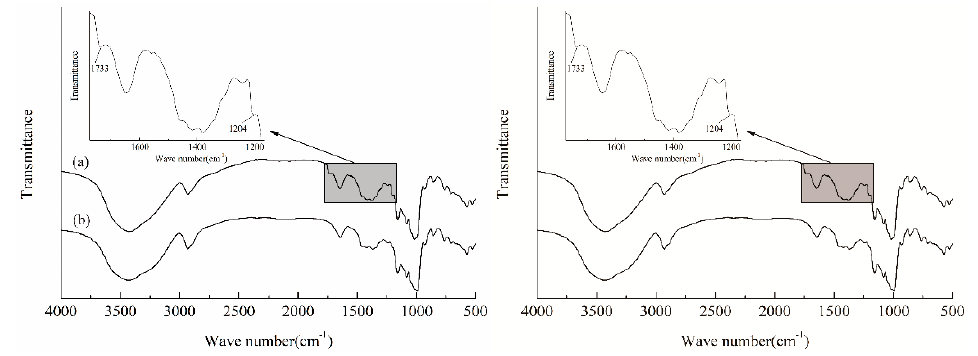
Figure 1. FTIR spectra of HCS (a), and ACS (b).